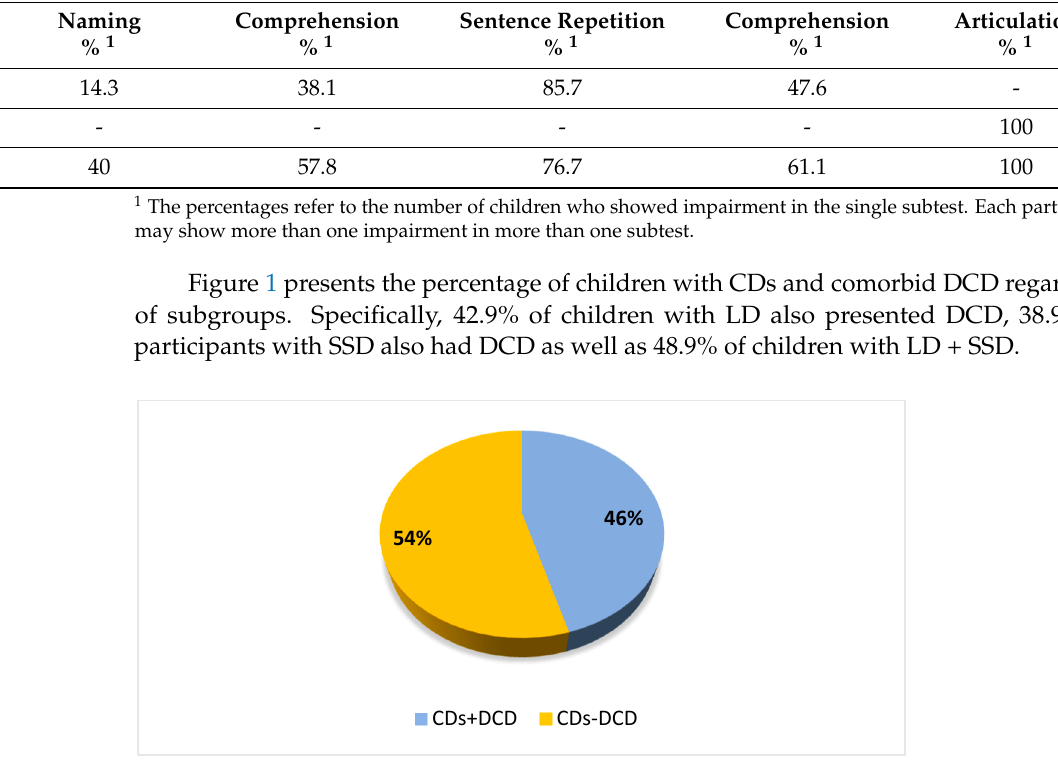
Figure 1. The percentage of children with CDs and a comorbid DCD regardless of subgroups. Legend: CDs + DCD = children with CDs and DCD; CDs-DCD = children with CDs without DCD.